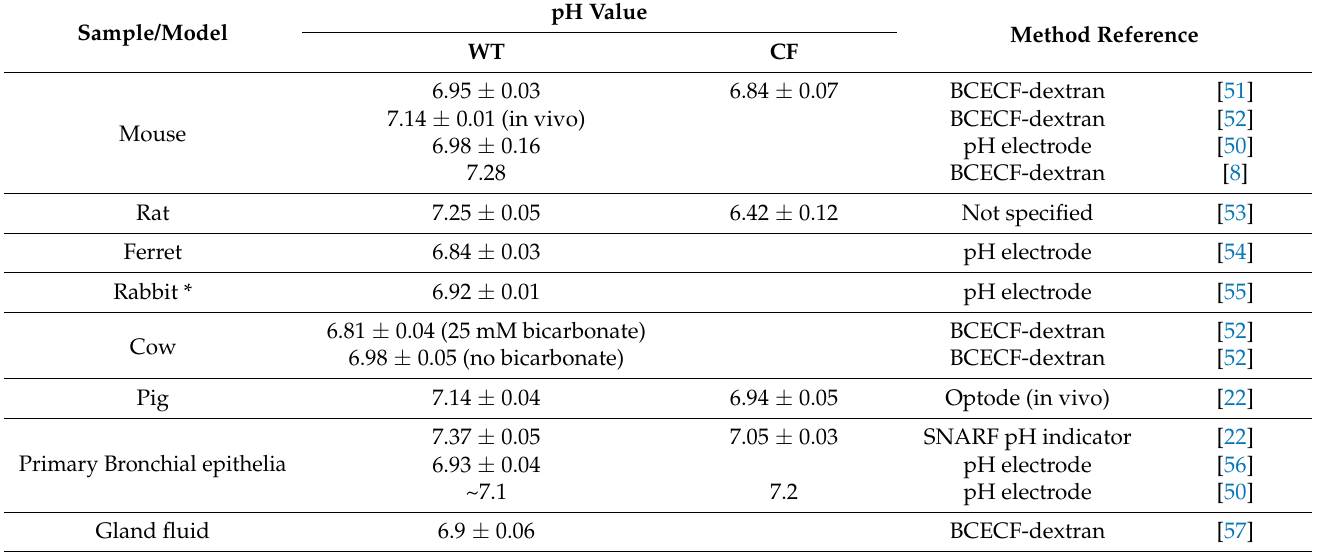
Table 1. Airway surface liquid (ASL) pH in animal models.